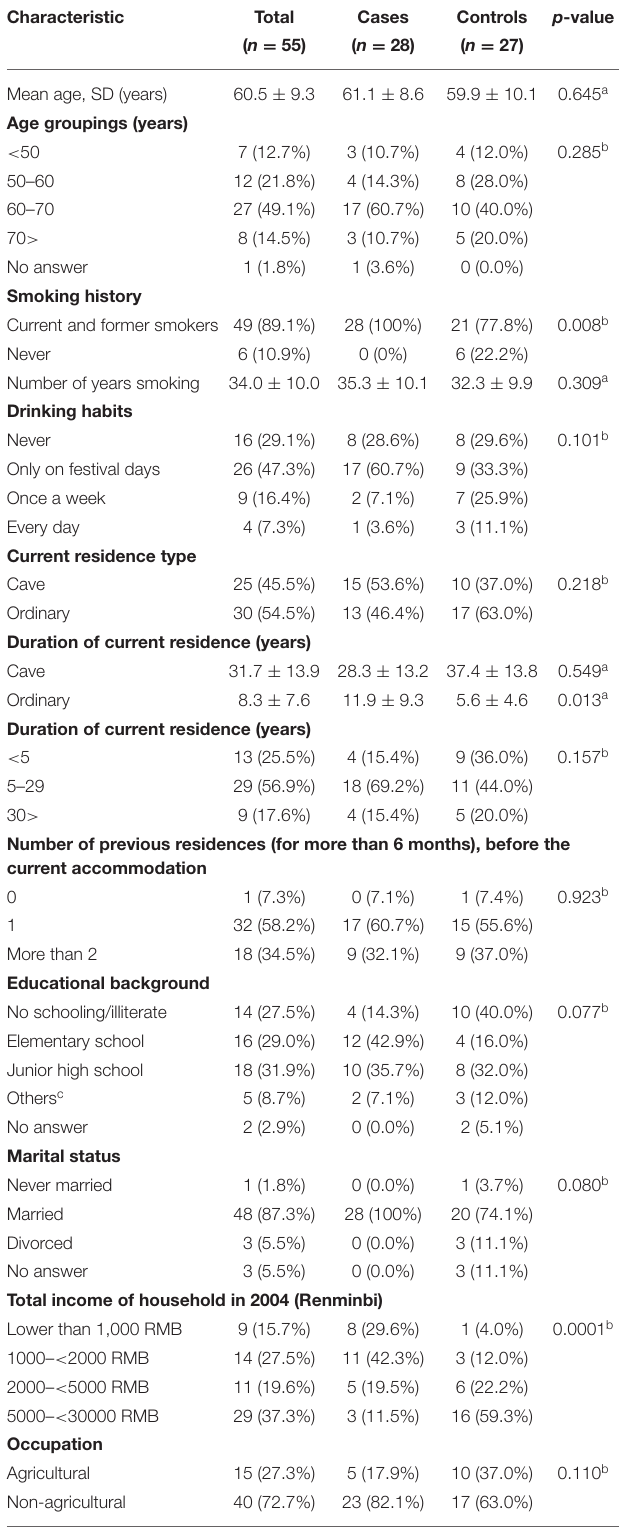
TABLE 1 | The demographic and other characteristics of the study